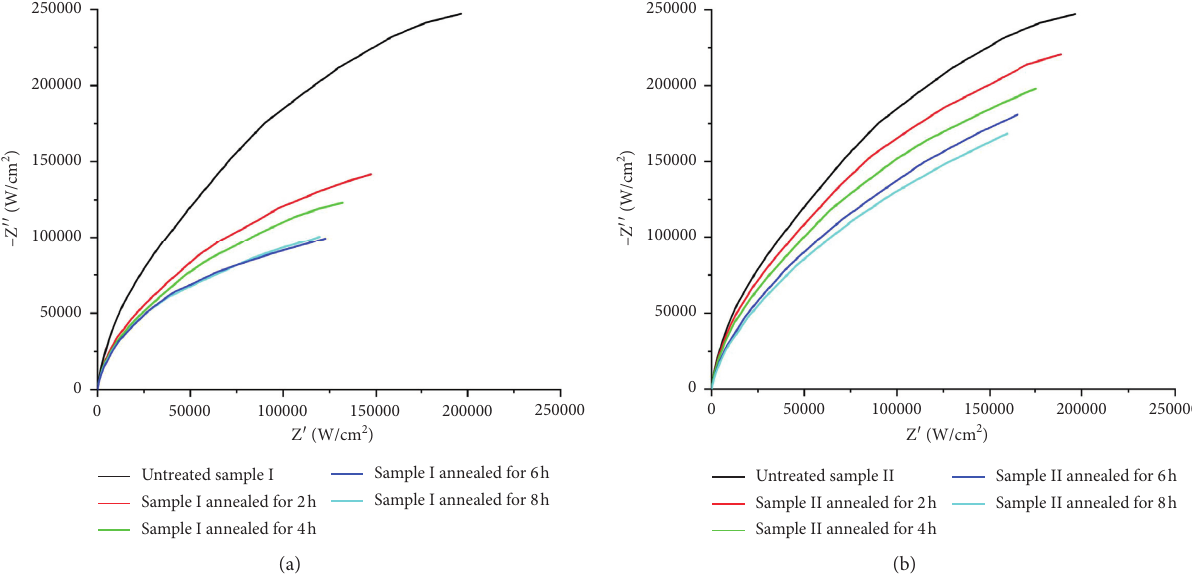
Figure 3: Nyquist curves of Sample I (a) and Sample II (b) with different annealing times.